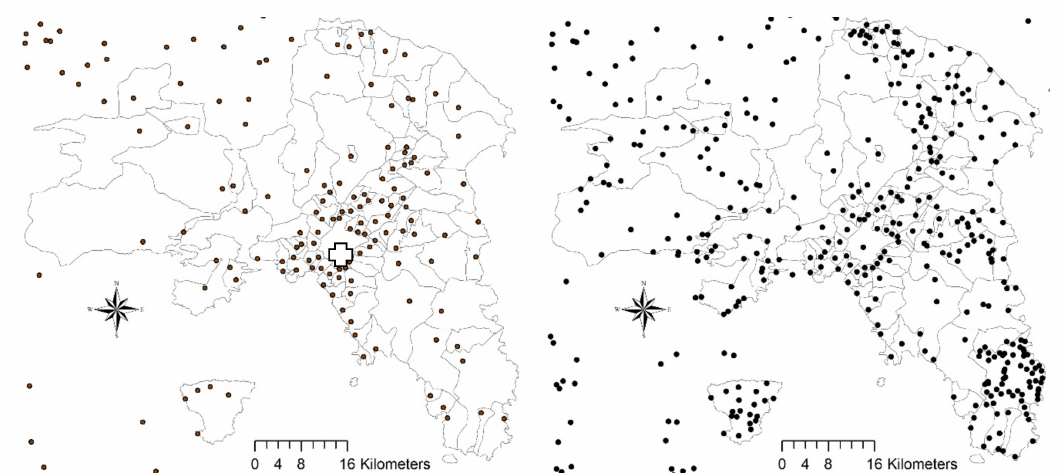
Figure 3. Municipal boundaries and spatial distribution of urban centers in 2011 (dots), with a cross indicating downtown Athens ( left ); spatial distribution of registered settlements (dots) in the Athens metropolitan region and surroundings in 2011 ( right ). (Source: elaboration on ELSTAT data and